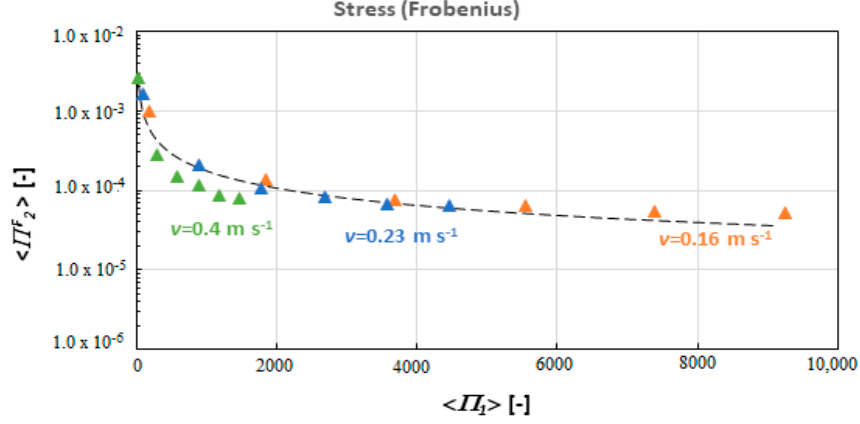
Figure 5. Relationship between average stress < Π F 2 > and < Π 1 >.